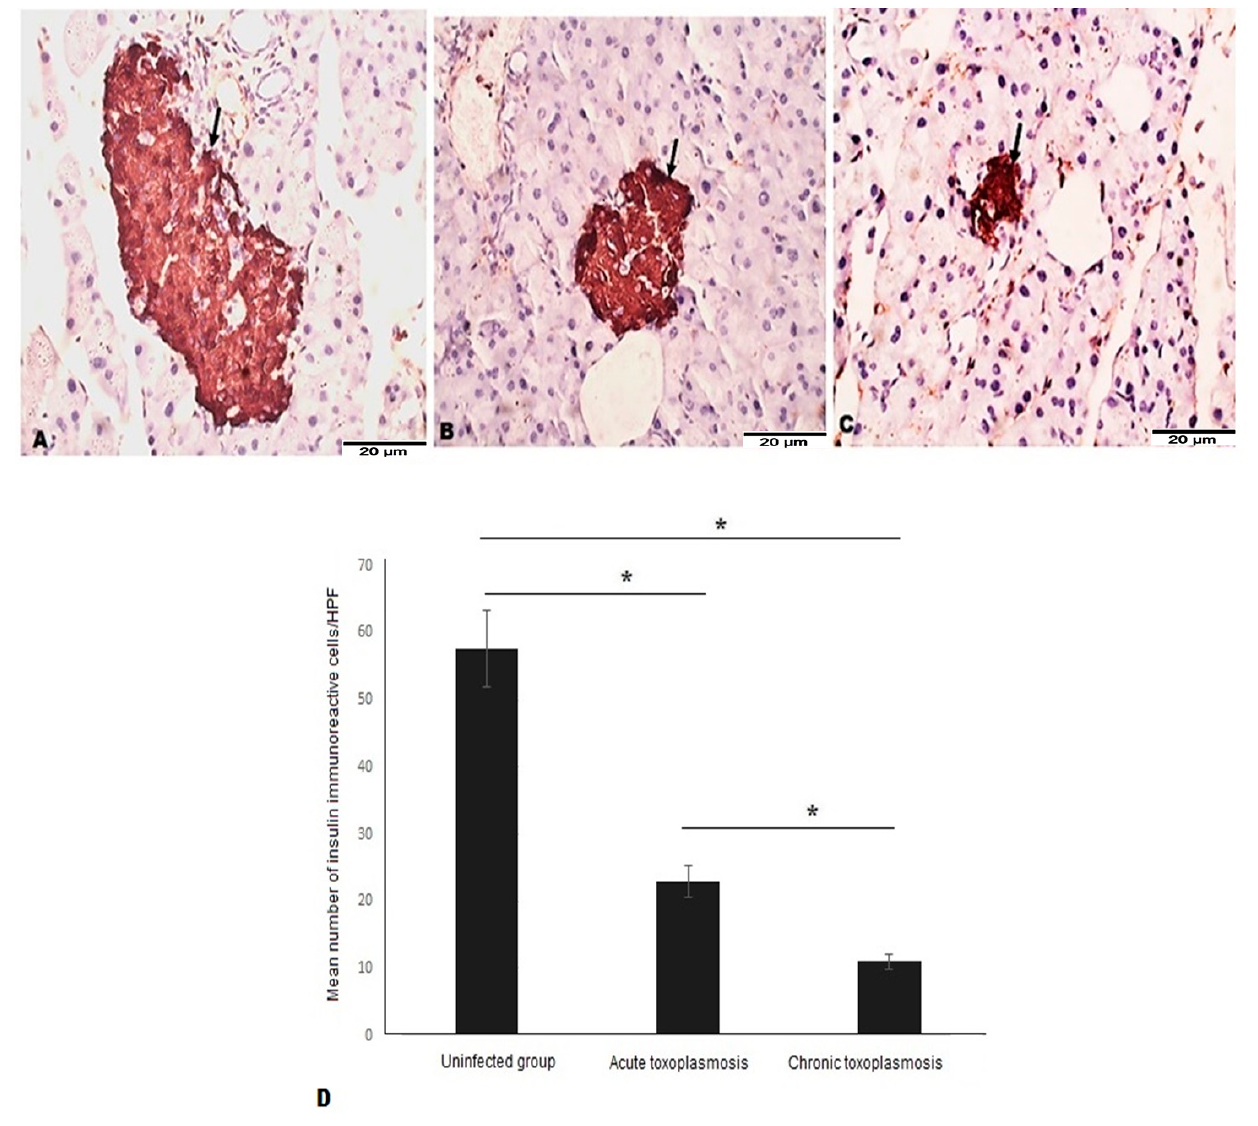
Figure 3. Acute and chronic toxoplasmosis are associated with significantly lower number of insulin- producing- β cells of islets of Langerhans. Pancreatic tissue sections of mice from different groups ( n = 10/group) were stained with anti-insulin antibody. ( A ) Representative image of pancreatic tissue sections of uninfected mice with strong insulin staining. ( B ) Representative image of pancreatic tissue sections of the acute toxoplasmosis group with smaller stained area of islets of Langerhans (fewer β cells) compared to uninfected group. ( C ) Representative image of pancreatic tissue sections of the chronic toxoplasmosis group with smaller stained area of islets of Langerhans (fewer β cells) compared to the acute toxoplasmosis group. ( D ) Number of β cells (insulin producing cells)/HPF in islets of Langerhans of different mice groups. Data are expressed as mean ± SD ( n = 10). Asterisks (*) indicate statistically significant difference; p < 0.05.